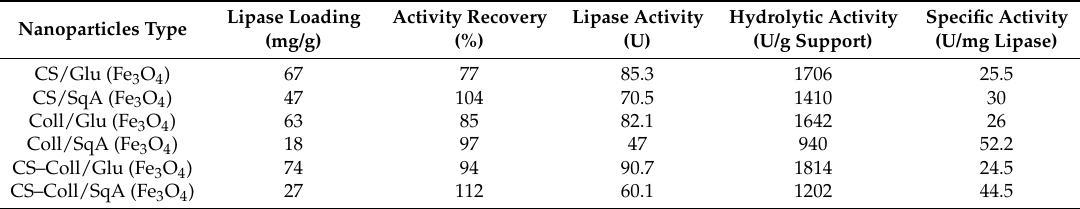
Table 2. Lipase from Candida rugosa immobilization